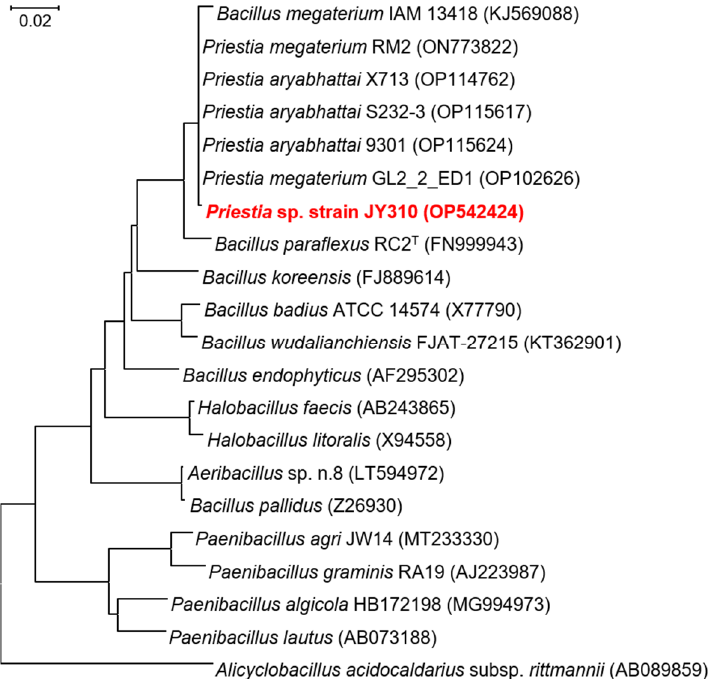
Figure 1. Neighbor-joining tree based on 16S rRNA gene sequences exhibiting the phylogenetic position of strain JY310 among its closely related strains. The nucleotide sequences used for phylogenetic analysis were retrieved from the GenBank database. Bar, 0.02 substitutions per nucleotide position.